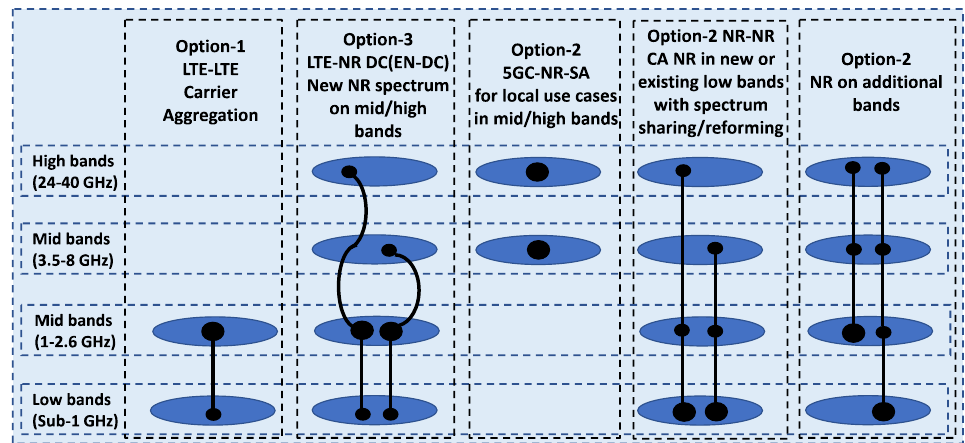
Figure 3. 5G NR-LTE